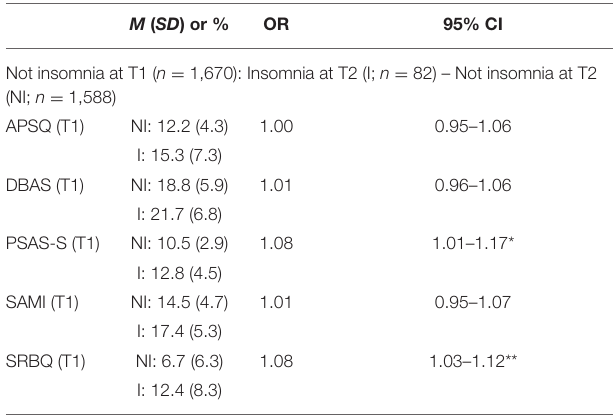
TABLE 3 | Cognitive processes at baseline between those with and without incident insomnia at the subsequent assessment: descriptive statistics and multivariate logistic regression